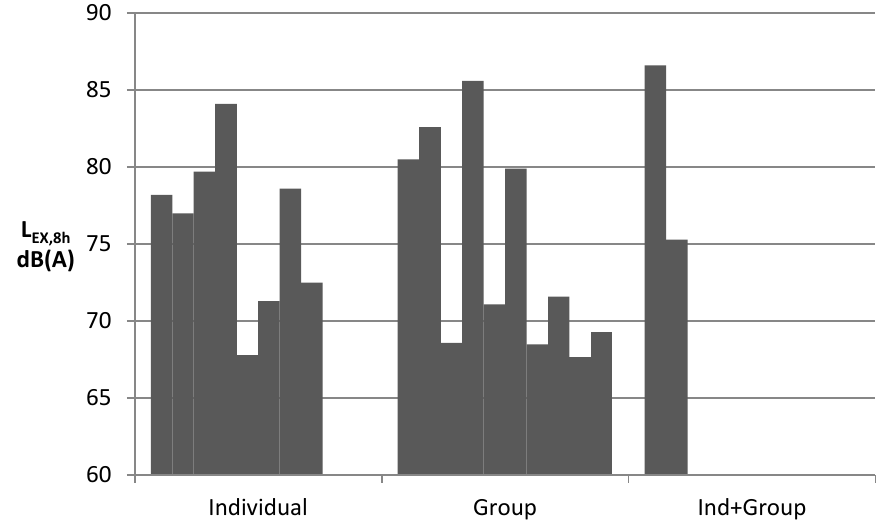
Figure 1. Daily noise exposure per class type.